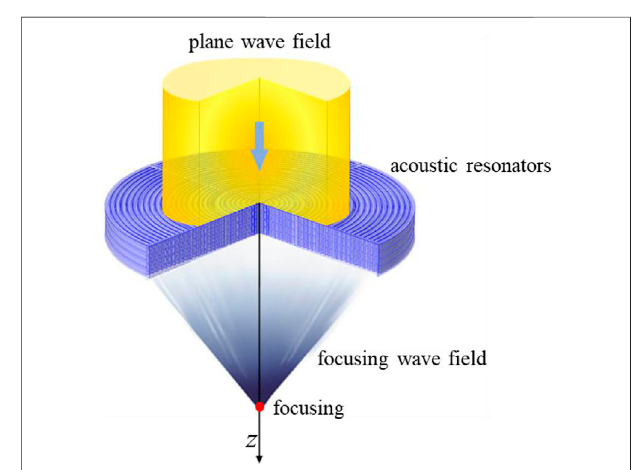
FIGURE 4 | Illustration of geometrical requirements necessary to establish an acoustic meta-lens converting an incident plane wave to an outgoing beam with a focusing